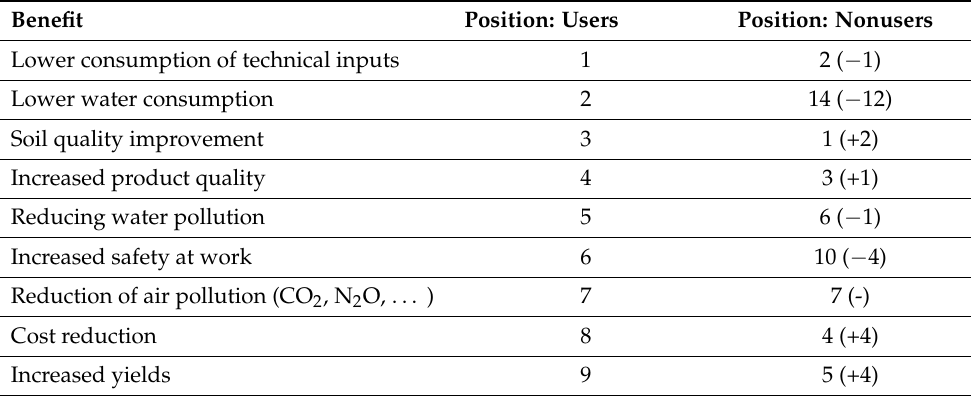
Table 12. Relative position of benefits.